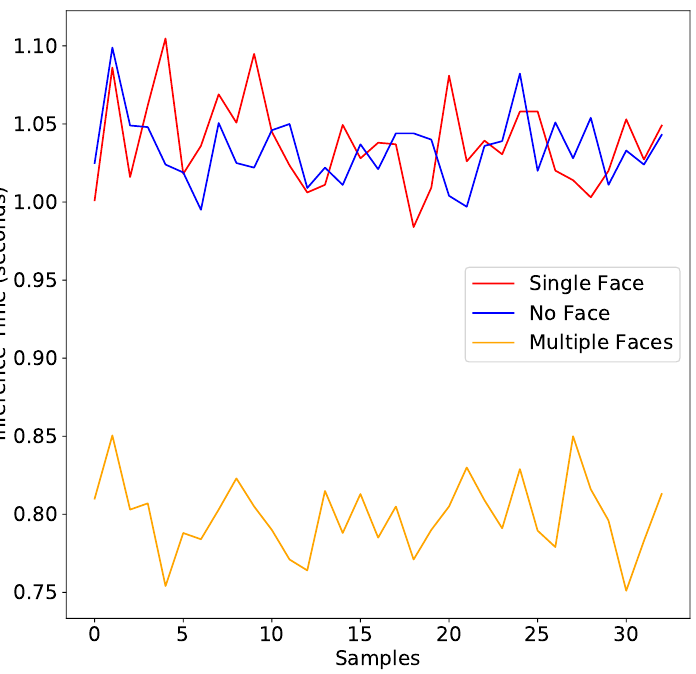
Figure 7. Inference time relation with samples on which YOLOv5 algorithm has been